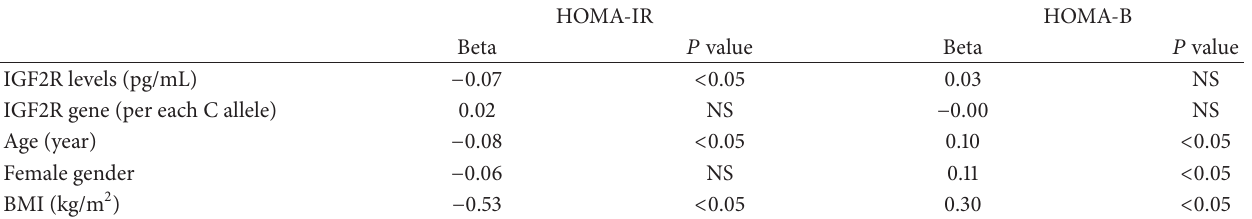
Table 5: The association between the HOMA models, circulating IGF2R, and the IGF2R